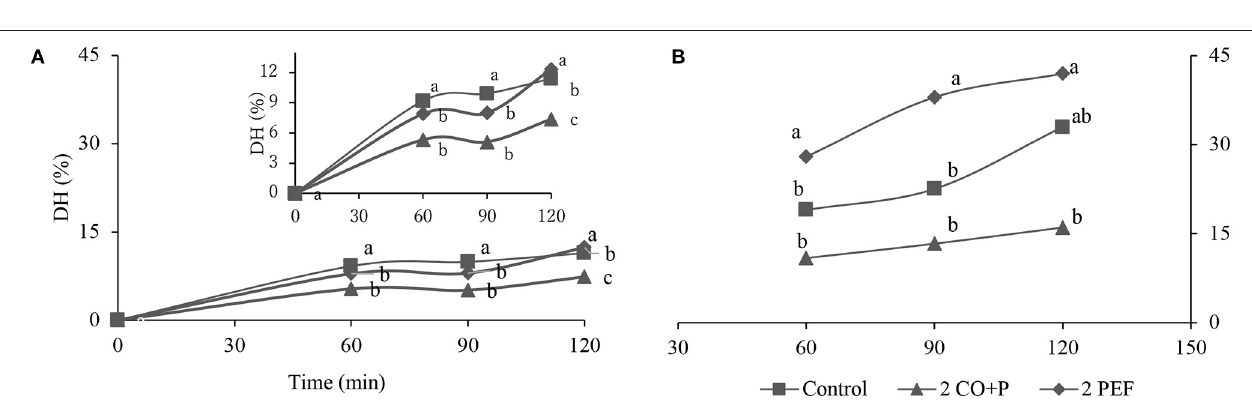
Frontiers in Nutrition |